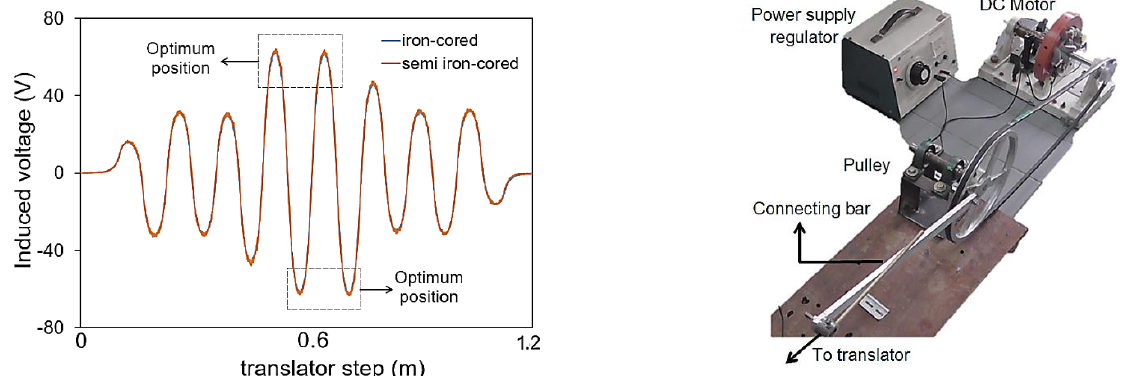
Figure 16. The induced voltage of the LPMGs under 1 m/s speed ( left ) and experiment setup with small-scale models ( right ).